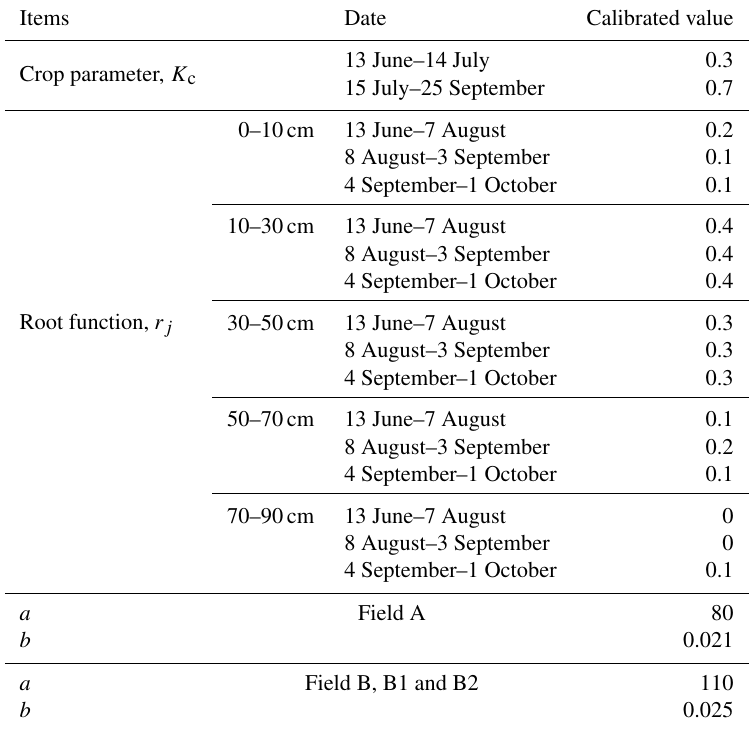
Table 6. Calibrated parameter values of the shallow-aquifer–vadose zone model.